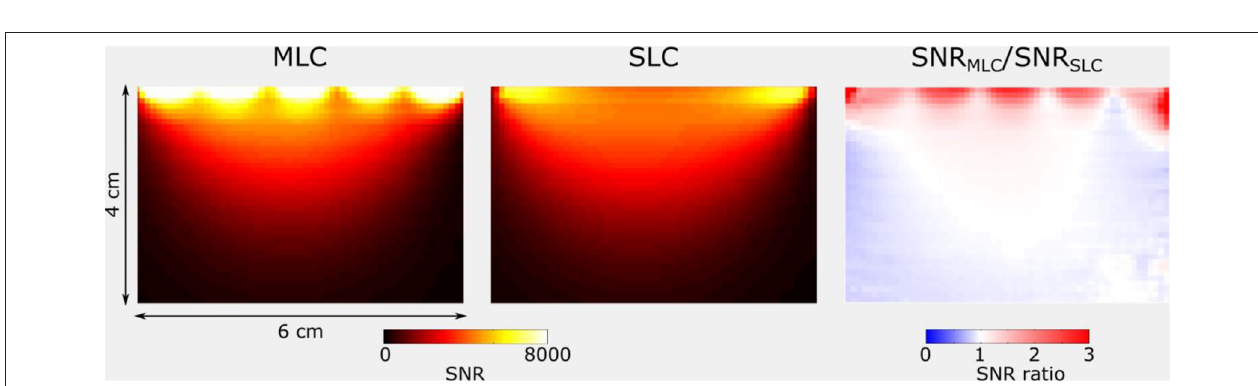
FIGURE 9 | SNR and ratio maps obtained for the central sagittal slice of 3D GRE acquisitions at 7T for MLC and SLC, respectively. Maps were cropped, so as to remove noise-only regions.